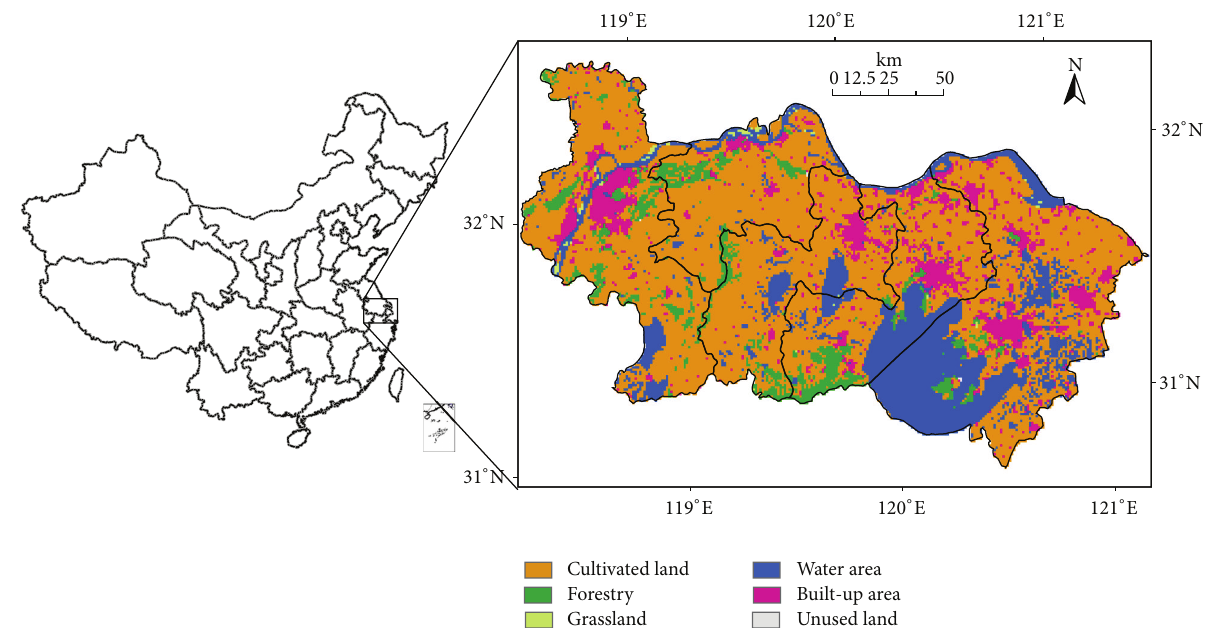
Figure 1: Location of